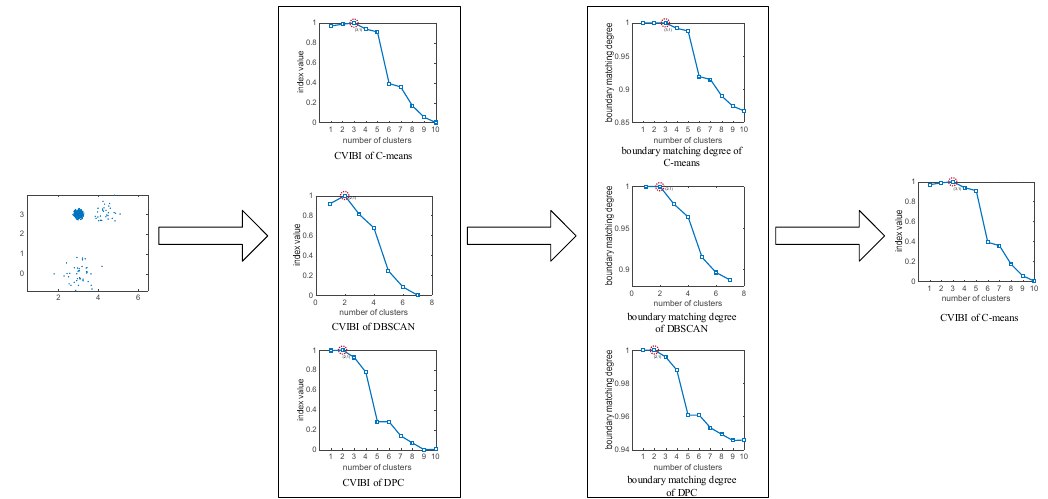
Figure 13. Evaluating process of CVIBI on density-diverse dataset.